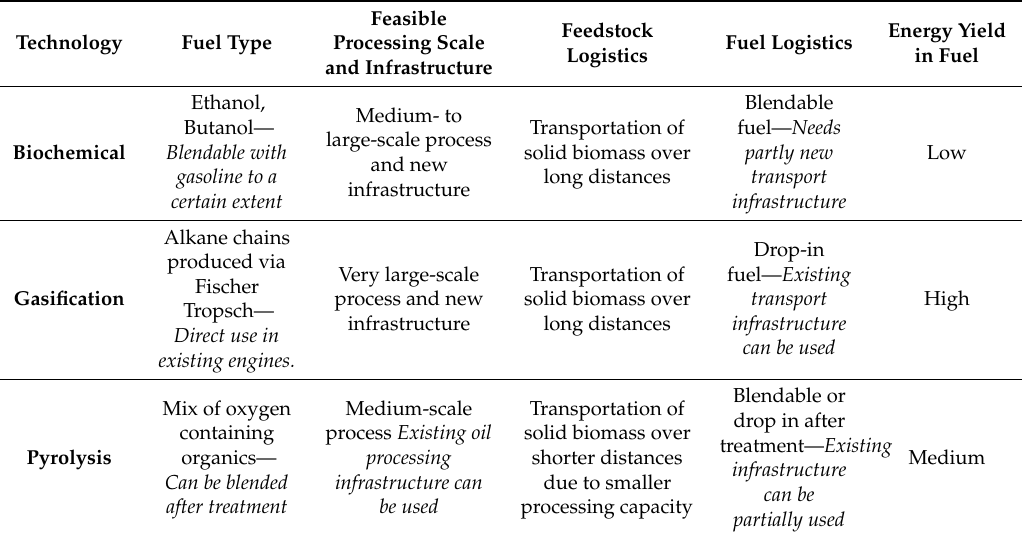
Table 1. Technology routes for second-generation